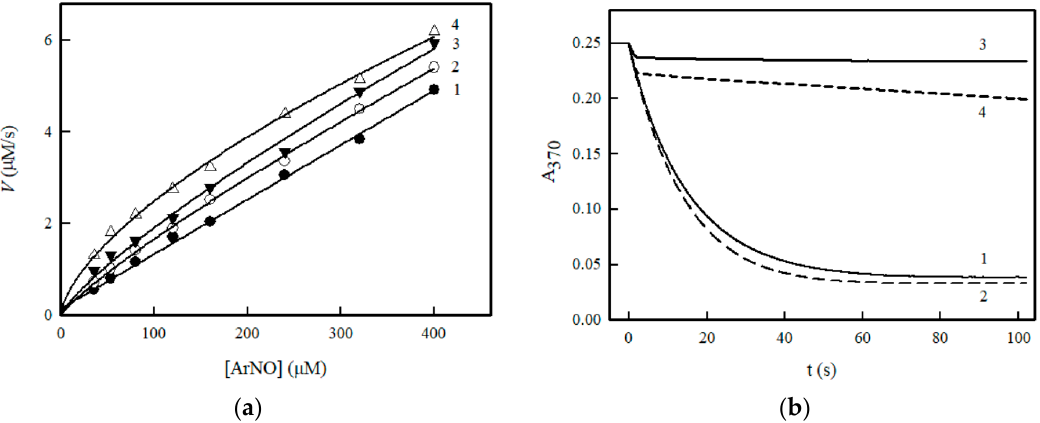
Figure 2. ( a ) Rates of oxidation of 100 µM NADPH by nitrosobenzene in the absence (1) and presence of NfsA (2–4). Enzyme concentration, 10 nM (2), 20 nM (3), and 40 nM (3); ( b ) Kinetics of oxidation of 100 µM NADPH by 400 µM nitrosobenzene in the absence (1,3) and presence (2,4) of 40 nM NfsA. Ascorbate (final concentration, 2 mM) was added into a syringe containing NADPH (3,4).